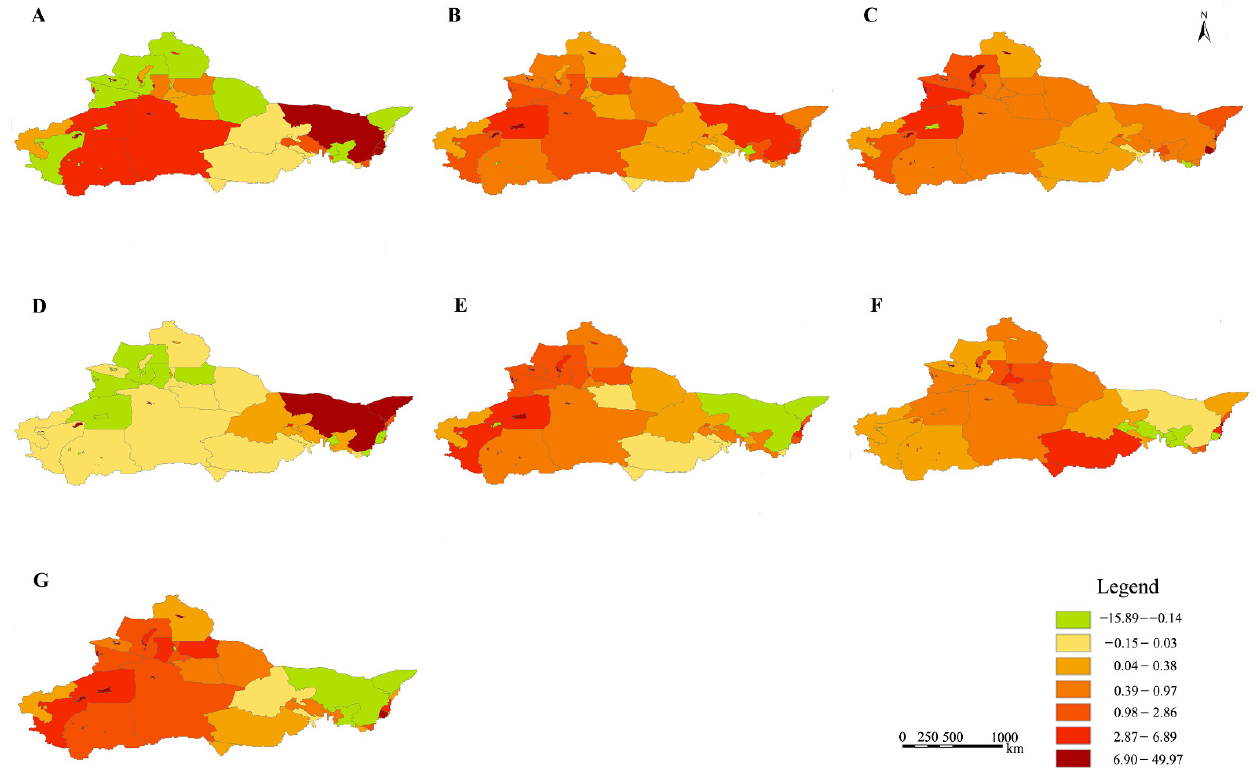
Figure 4. Relative dynamic degree of grasslands in the arid desert region of Northwest China, ( A )